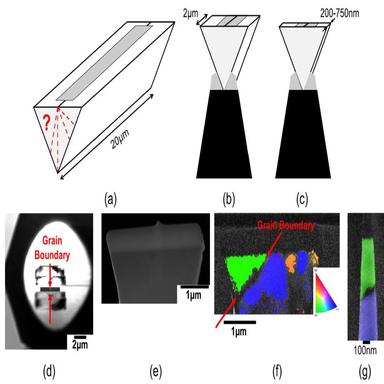
Schematic diagram of (a) lift-out bar containing a straight section of a grain boundary on the surface and some potential locations of the grain boundary underneath the surface, (b) lift-out section mounted on a microtip, (c) lift-out section thinned to 200–750 nm in thickness. (d) SEM image of plan view of a lift-out section thinned to 200–750 nm in thickness, (e) side view of a thinned lift-out section, (f) Indexed pole figure (IPF) generated from TKD data for the thinned lift-out section, and (g) IPF for